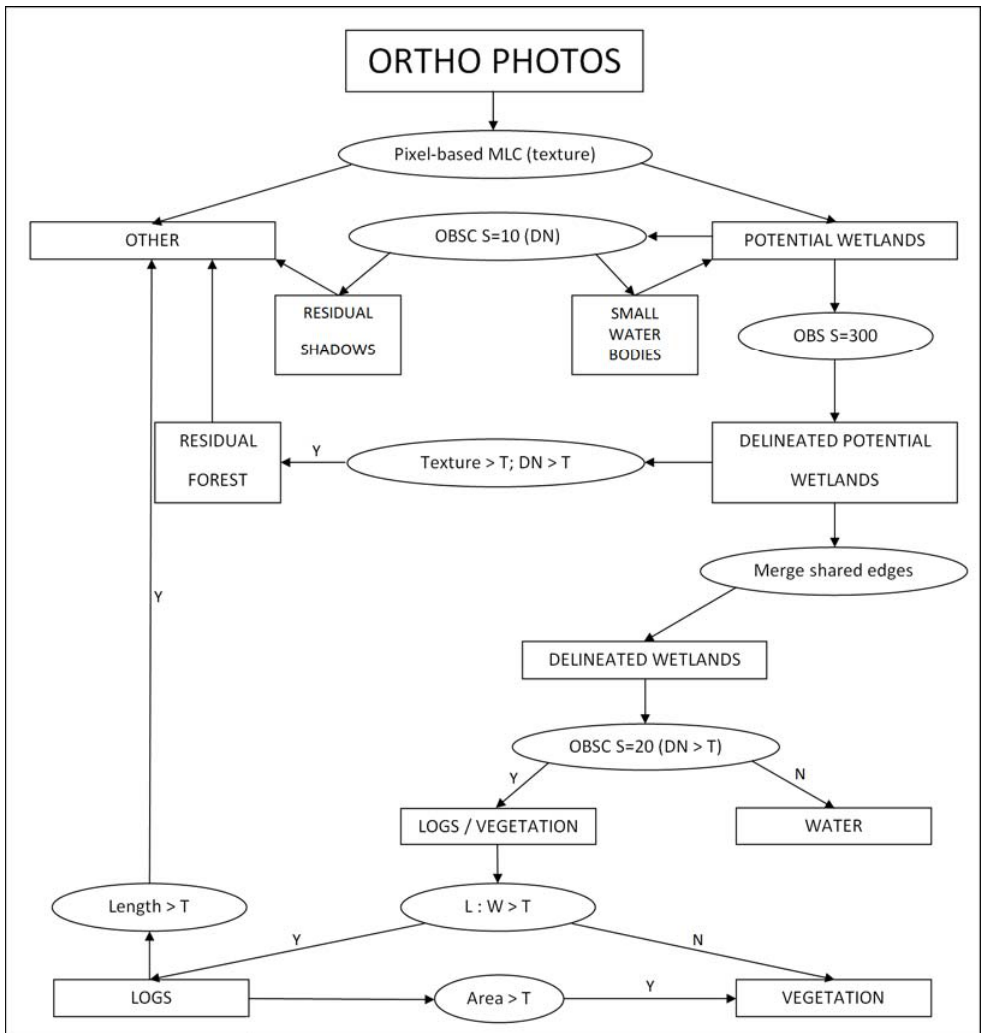
Figure 5. Image classification steps to produce segmented and classified wetlands and within wetland habitat features of water, vegetation and logs. Rectangles are image products; ellipses are processes. MLC = maximum likelihood classification. OBSC = object-based segmentation and classification. For each segmentation, the scale value (S) is given. For each classification the discriminating variable type is given. T = data threshold as described in the text. DN = image brightness digital number. L = length. W =